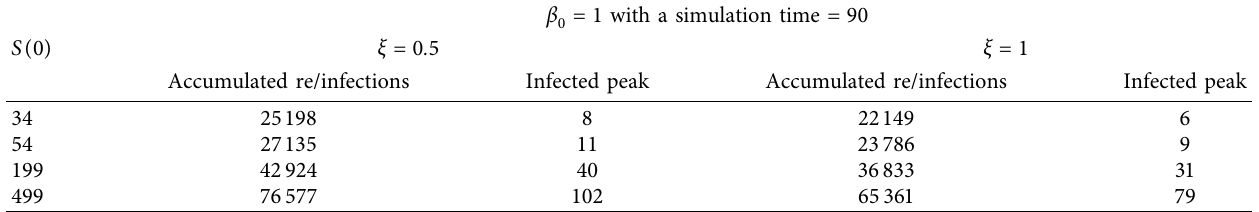
� 1, Λ � 10, and p � 0 . 1. 0